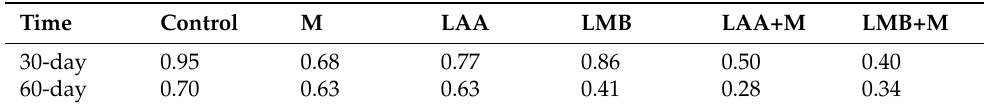
Table 3. The apparent diffusion fluxes of P (mg · m − 2 · d − 1 ) at sediment–water interfaces among different experimental treatments.